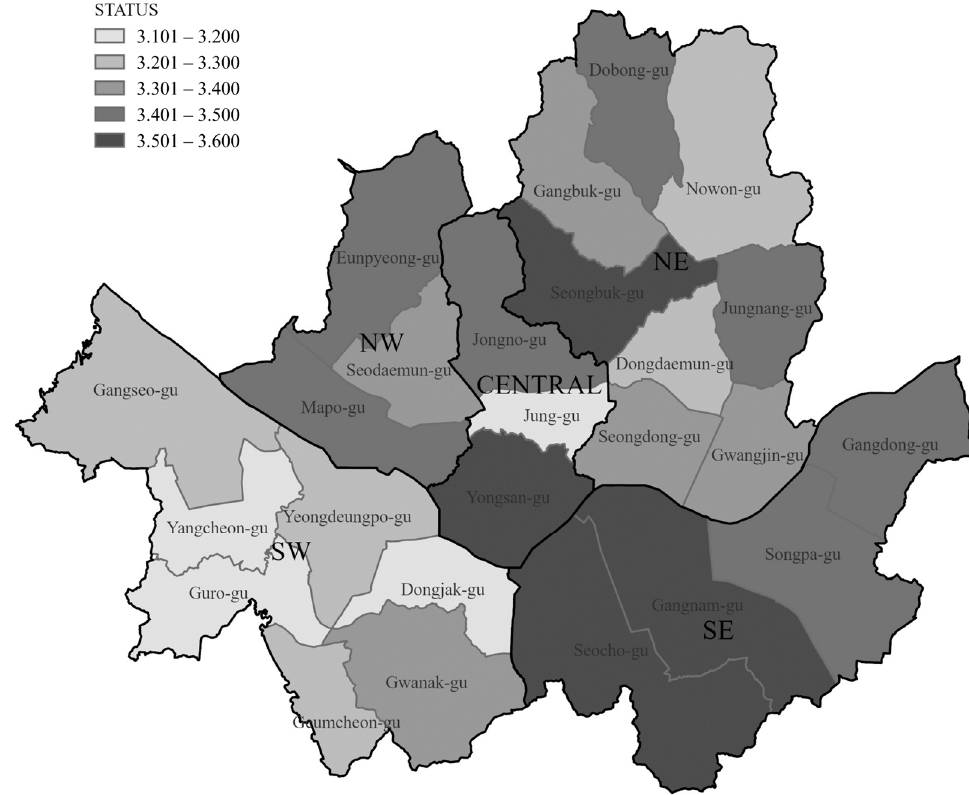
Figure 4. Subjective socioeconomic status by the residential neighborhood (Gu). Table 2. Descriptive statistics.